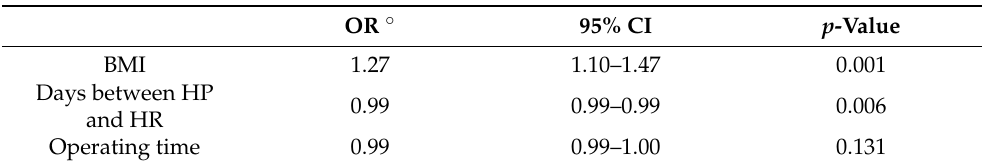
Table 6. Multivariate logistic regression of the factors associated with the presence of Incisional Ventral Hernia